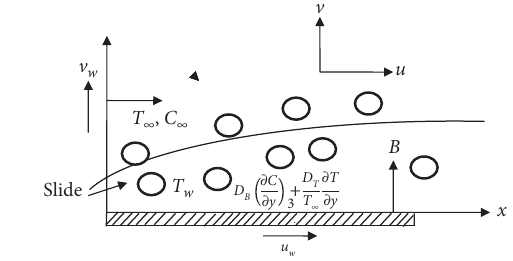
Figure 1: Diagrammatic of the